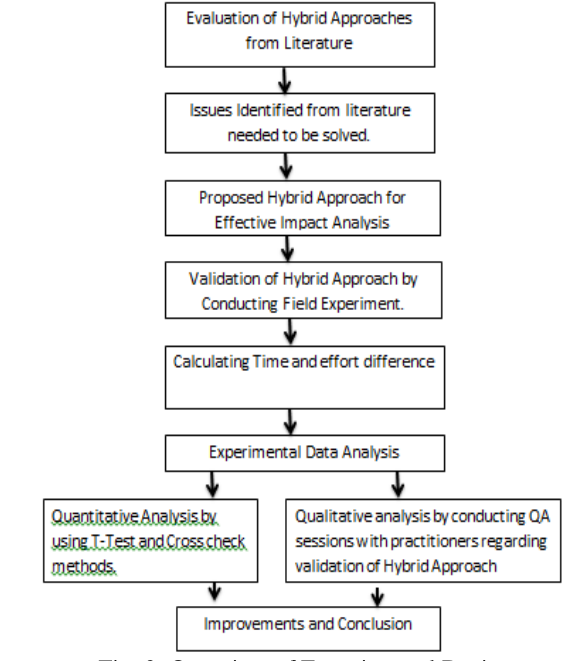
Fig. 2. Overview of Experimental